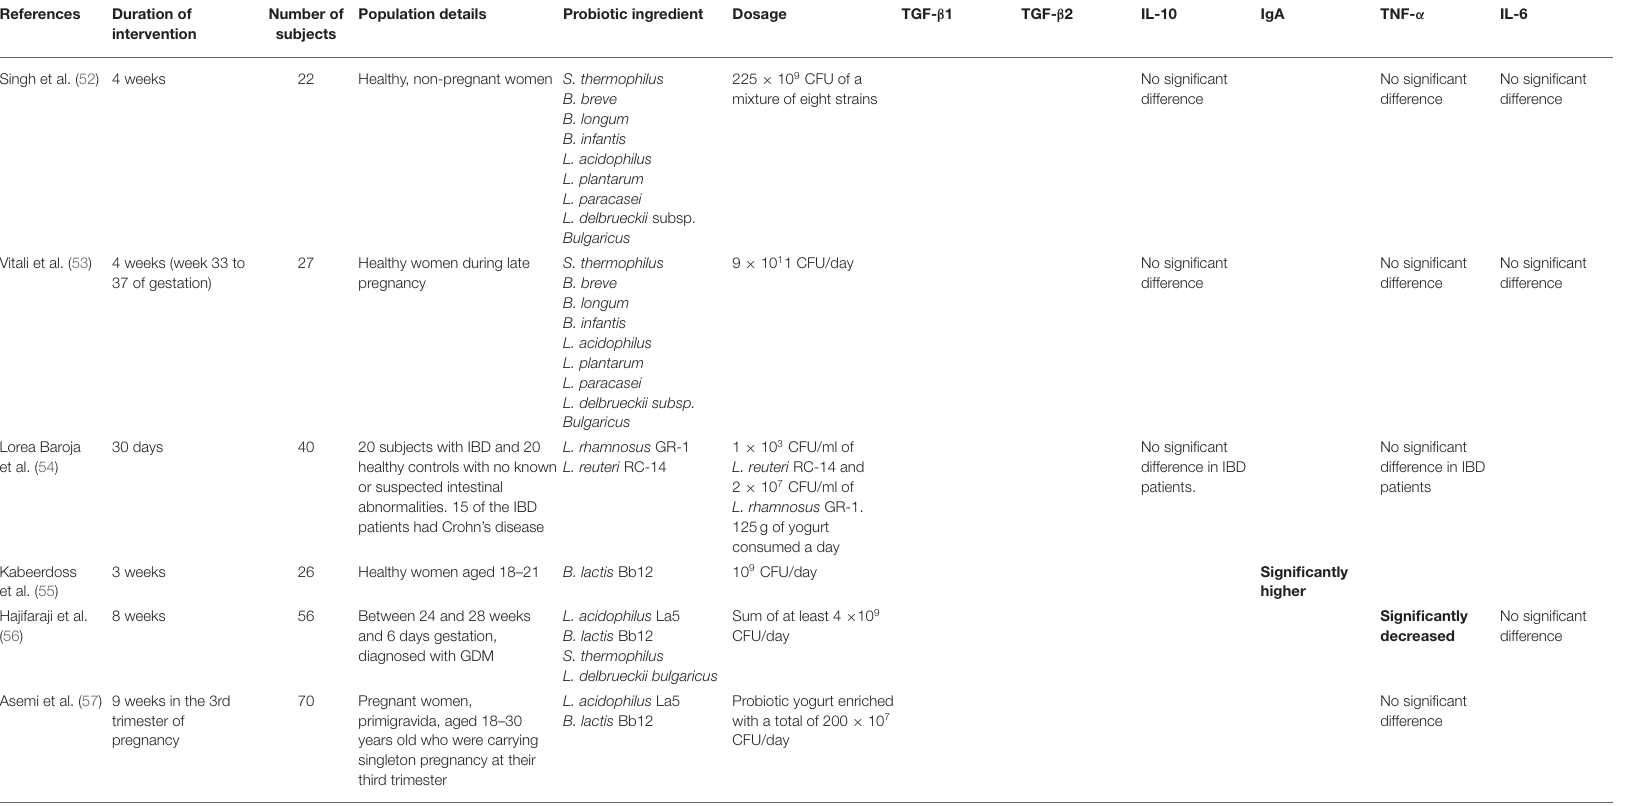
Significant differences in cytokines or IgA are highlighted in